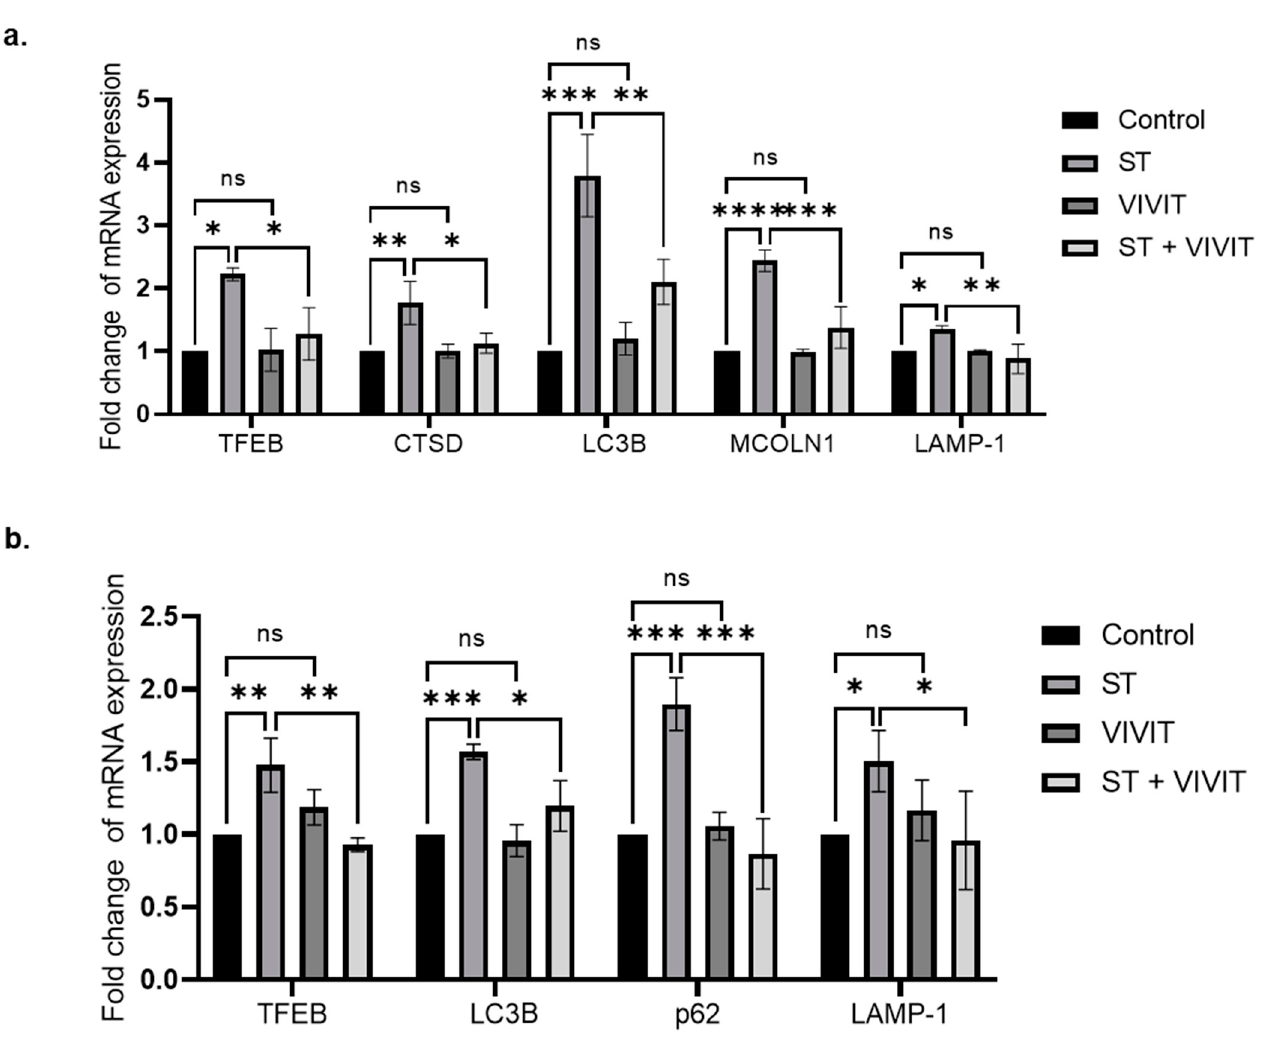
Figure 4. NFAT-mediated regulation of TFEB expression and CLEAR network genes. ( a ) qRT-PCR analysis of the expression of TFEB and TFEB downstream targets: lysosomal genes (CTSD, LAMP-1 and MCOLN1) and autophagy genes (MAP1LC3B) upon VIVIT treatment (20 µ M) in ARPE-19 cells subjected to nutrient deprivation for 48 h. ( b ) qRT-PCR analysis of the expression of TFEB and TFEB downstream targets: lysosomal (LAMP-1) and autophagy genes (MAP1LC3B and p62) upon starvation and VIVIT (20 µM) treatment for 48 h in HPV E6/E7 immortalized mouse RPE cells. Values represent mean ± s.d. of at least three independent experiments. One-Way ANOVA was used for analysis p -value. The p -value is stated as * p < 0.05, ** p < 0.01, *** p < 0.001, **** p < 0.0001. (ST indicates starvation).